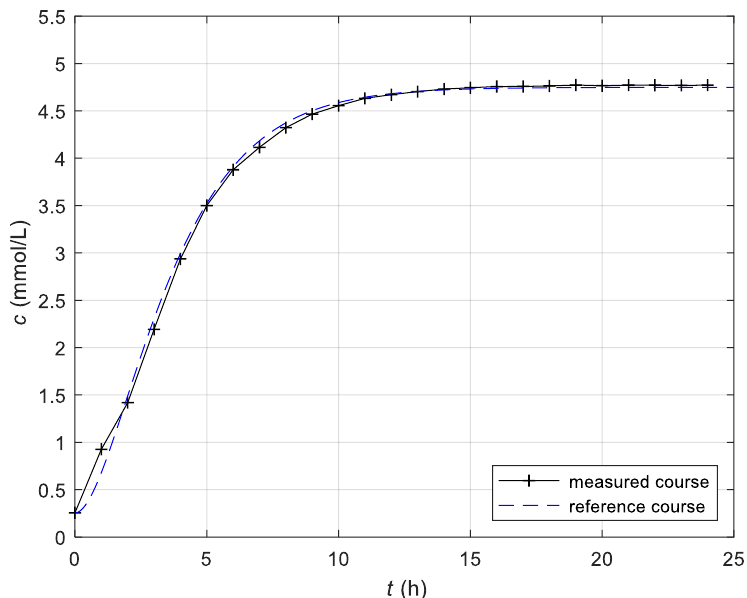
Figure 8. Reference and measured time courses of the CO 2 when the proposed control system was used.